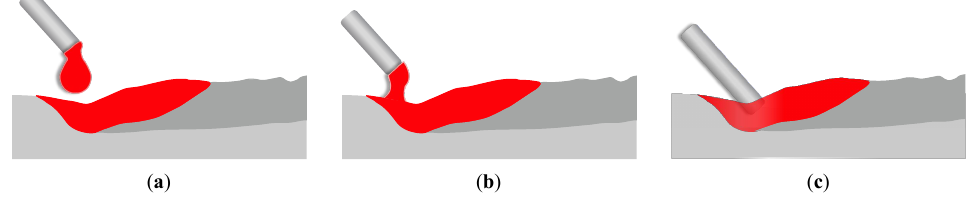
Figure 1. Metal transfer modes in the WAAM process: ( a ) droplet transfer mode, ( b ) liquid bridge mode, and ( c ) wire stubbing transfer mode.